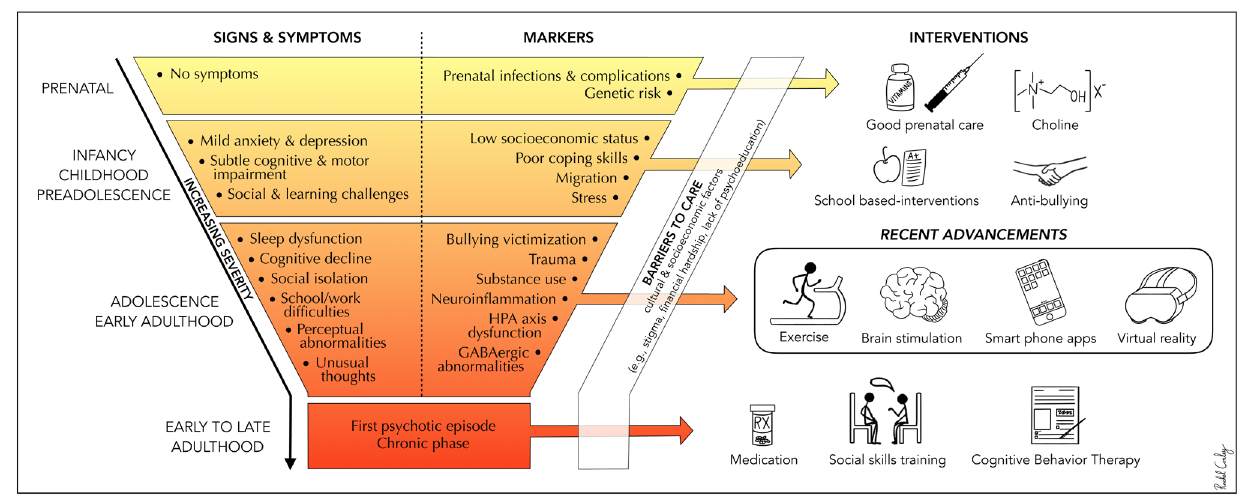
Figure 1. Signs, symptoms, markers, and interventions from a clinical staging perspective in psychosis risk syndromes. Many of the signs and markers may occur in different stages and overlap between stages. Furthermore, it is important to note that many of the individuals who may exhibit signs and symptoms that put them on the trajectory toward developing a psychotic disorder may not go on to develop a diagnosis and instead may improve or develop a different psychopathology. HPA,